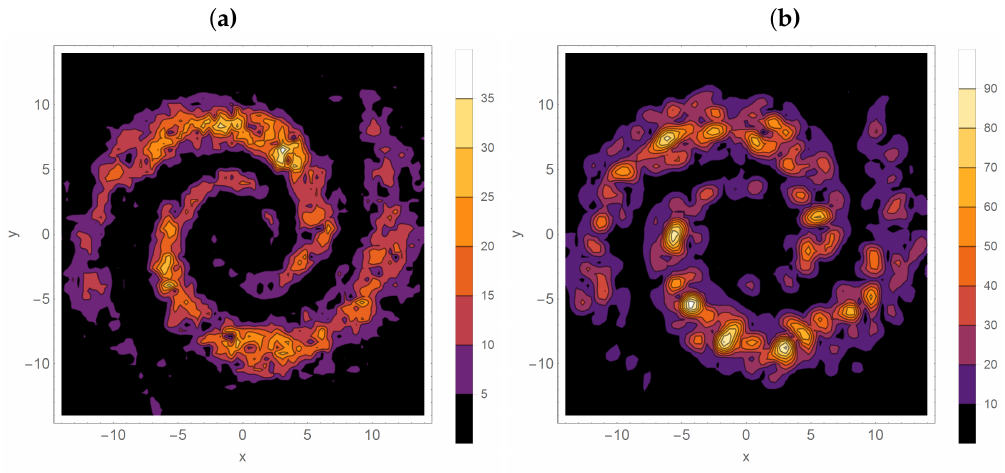
Figure 4. Distributions for a model which consists of large scales and small scales (no noise): ( a ) F max , ( b ) w max . Colour scale shows values in µ